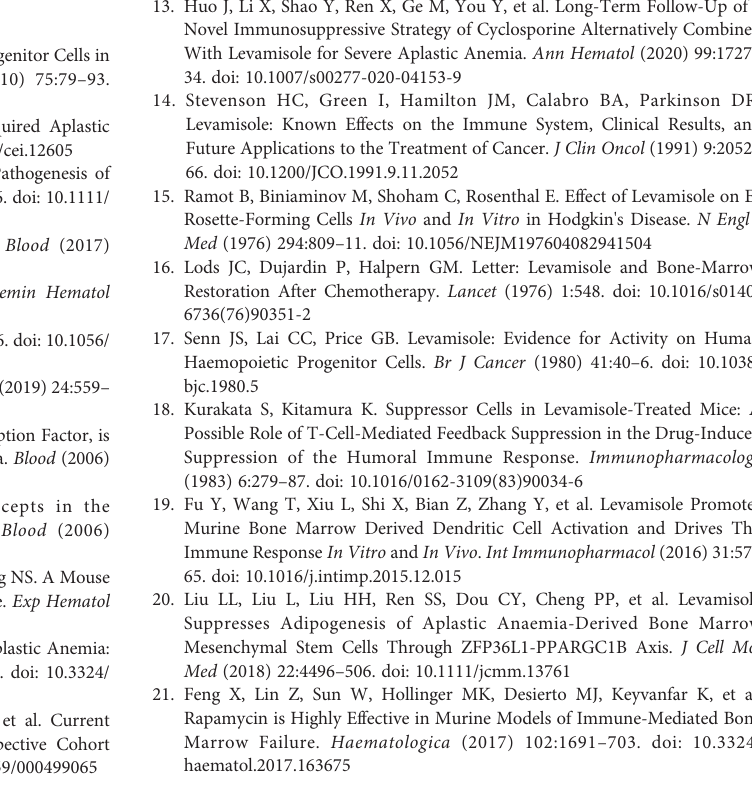
Supplementary Figure 1 | Peripheral blood cell changes and cytokine secretion in serum in NSAA patients before and after receiving CSA+LMS based regimen. (A – C) Reticulocytes counts, the percentage of monocytes and lymphocyte counts in NSAA patients at de-novo (untreated), the time point after 3-6 months of standard CSA therapy with poor response before administration of CSA+LMS based regimen (CSA treated), and the time point after the CSA+LMS based regimen with good response (CSA+LMS). (D – H) Percentages of B cells, NK cells, NK/T cells, CD3 + T cells and Tregs in these three stages in this cohort by fl ow cytometric analysis. (I) Cytokine secretion in the serum in the CSA treated and CSA+LMS stages in this cohort. *P< 0.05,